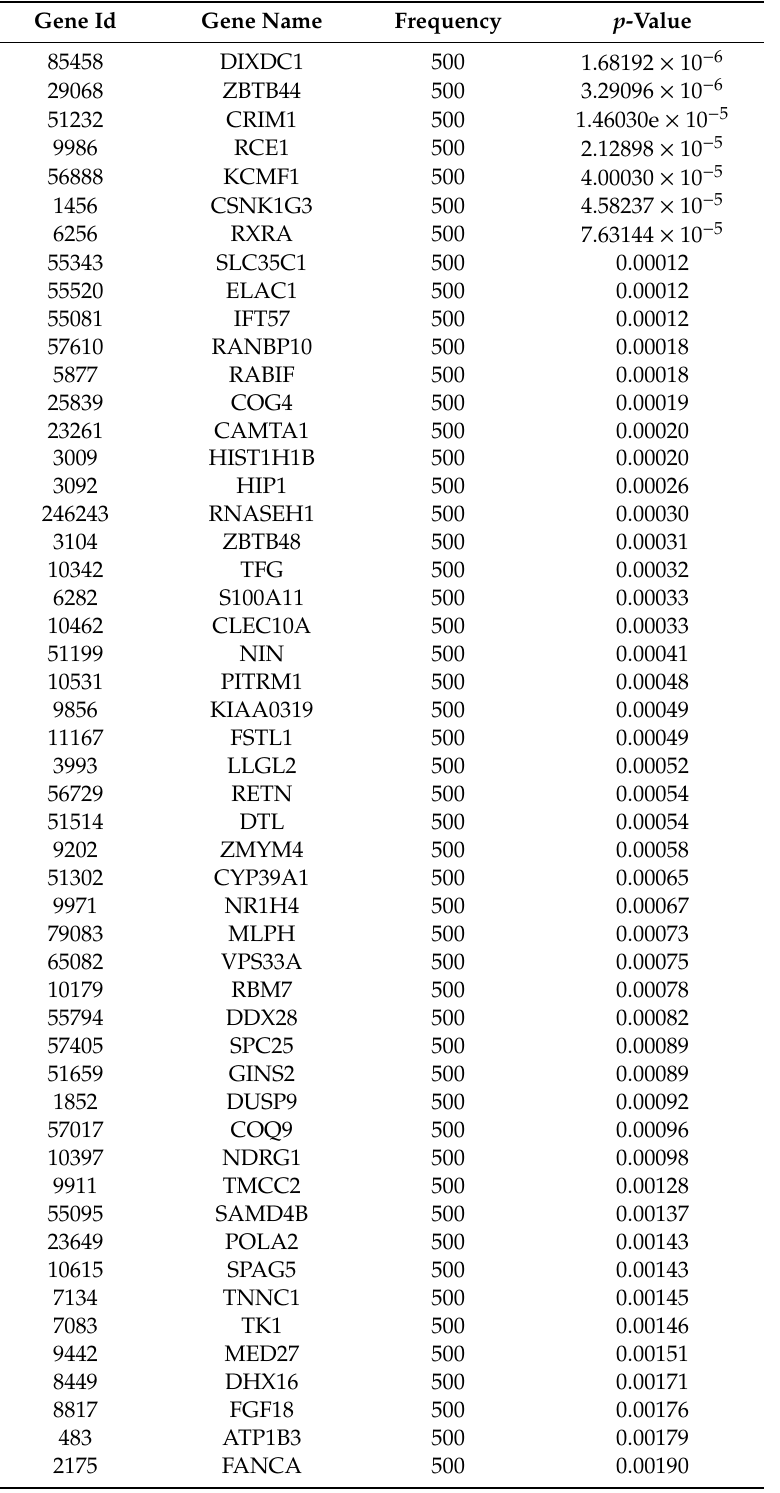
Table 2. The signature genes in our